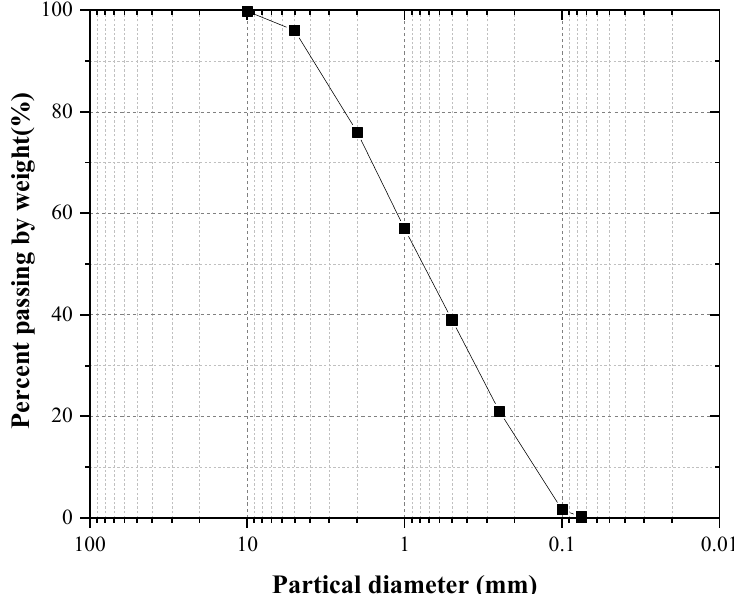
Figure 2. The particle grading curve. Table 1. Physical properties of the tested soil sample.